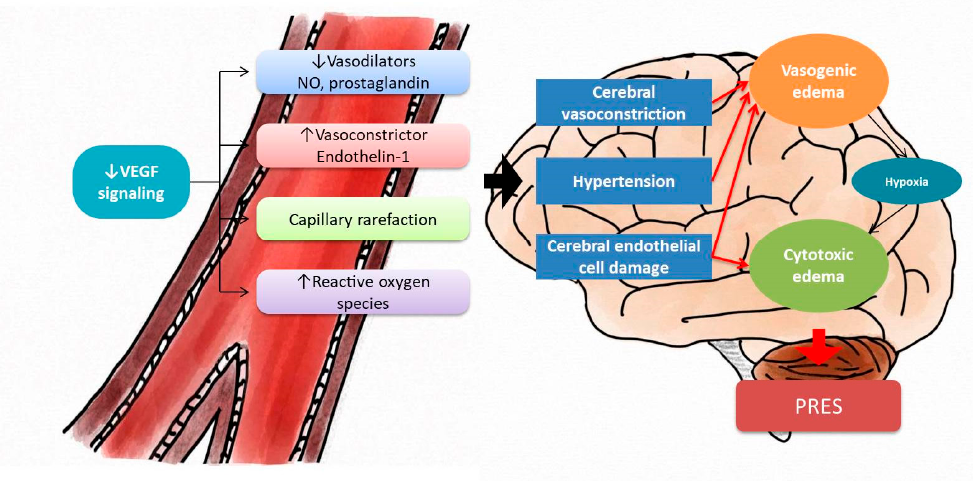
Figure 4. The hypothesis of anti-VEGF signaling induces PRES. Anti-VEGF signaling causes in- creasing peripheral resistance and, consequently, leads to hypertension. In addition, the anti-VEGF pathway results in endothelial dysfunction. Both hypertension and endothelial dysfunction dam- age the blood–brain barrier and increase vasogenic edema, and further cause cytotoxic edema by hypoxia. Endothelial cell damage itself contributes to cytotoxic edema. The sum of vasogenic edema and cytotoxic edema leads to PRES. VEGF = vascular endothelial growth factors; PRES = posterior reversible encephalopathy syndrome.